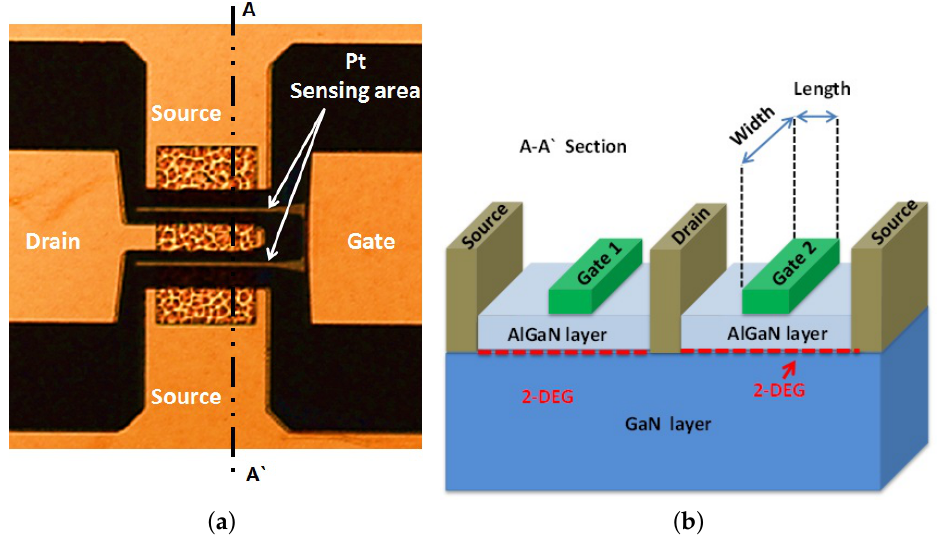
Figure 2. ( a ) Processed HEMT sensor device; ( b ) cross-section of the AlGaN/GaN HEMT structure.